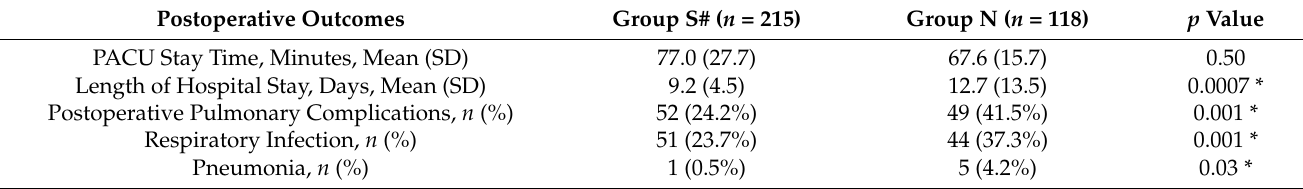
Table 3. Postoperative